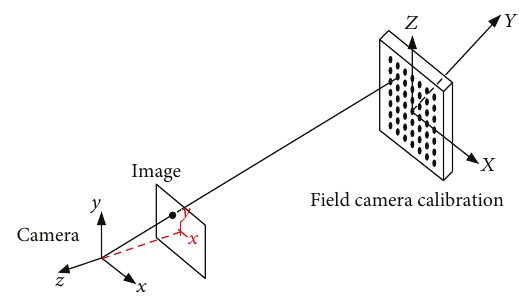
Figure 15: Calibration fi eld, camera, and image reference